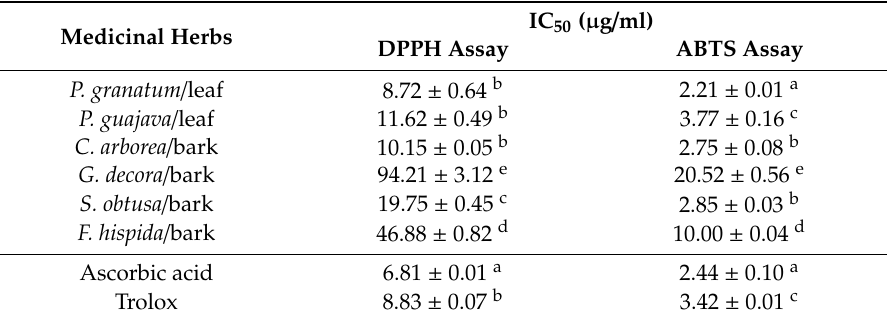
Table 3. Antioxidant activity of the EtOH extracts by DPPH and ABTS methods. Medicinal